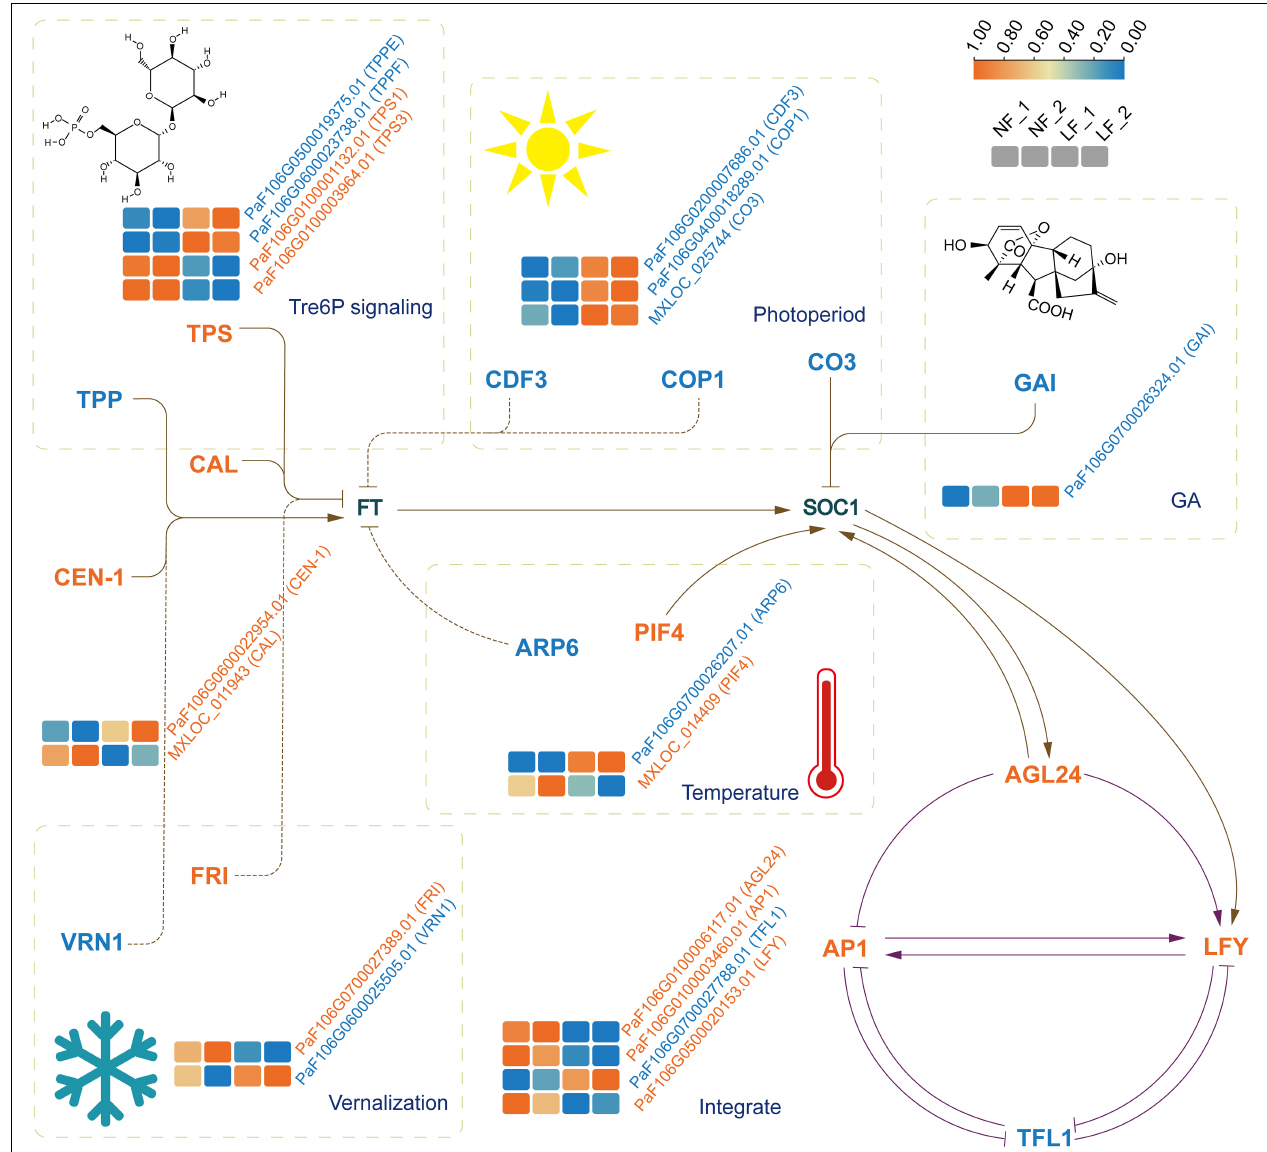
FIGURE 3 | The expression profiles of genes implicated in floral transition from six pathways. The four boxes (left to right) in one row of each heat map correspond to the expression levels in NF_1, NF_2, LF_1, and LF_2, respectively. TPS, trehalose-6-phosphate synthase, TPP, trehalose-6-phosphate phosphatase, CDF3, cycling dof factor 3; COP1, constitutively photomorphogenic 1; CO3, CONSTANS like 3; GAI, GA insensitive; ARP6, actin related protein 6; PIF4, phytochrome interacting factor 4; FRI, FRIGIDA; VRN1, vernalization 1; AGL24, agamous like24; AP1, apetala1, LFY, LEAFY; TFL1, terminal flower 1. Full and dashed lines indicated the directly and indirectly acting, respectively. Arrows meant positive relationships and stubs meant the opposite relationships.